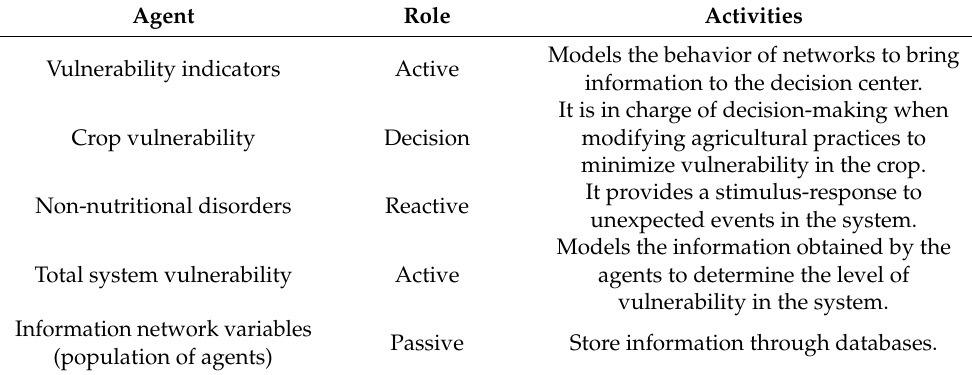
Table 1. Agent classification.